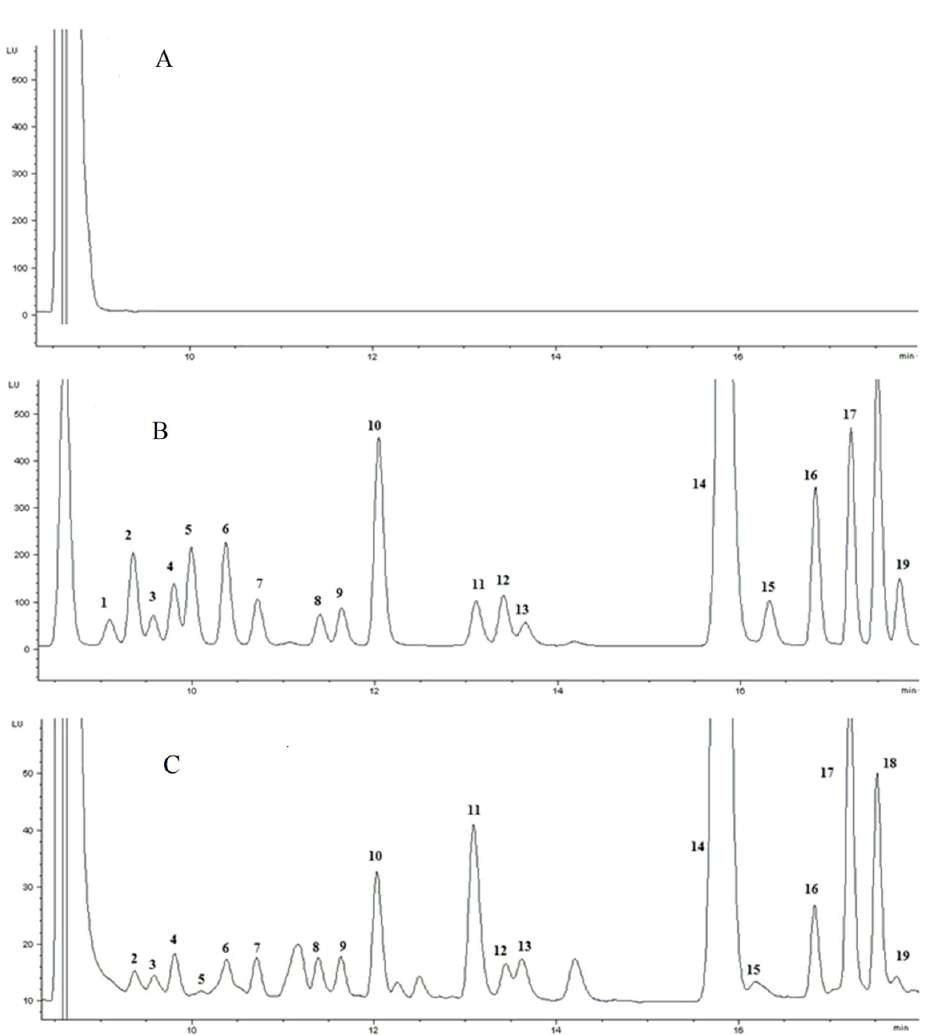
Figure 3. Representative chromatograms for blank ( A ), standards ( B ) and the typical chromatograms for the amino acids derivatives in peel and pulp of Nitraria tangutorum Bobr. ( C ) peak labels: 1. cysteine HCl (Cys), 2. Histidine (His), 3. ornithine (Orn), 4. arginine (Arg), 5. lysine (Lys), 6. Serine (Ser), 7. aspartic acid (Asp), 8. glutamic acid (Glu), 9. threonine (Thr), 10. Glycine (Gly),11. tryptophan (Trp), 12. alanine (Ala), 13. tyrosine (Tyr), 14. proline (Pro), 15. methionine (Met), 16. valine (Val), 17. phenylalanine (Phe), 18 isoleucine (Ile and 19. leucine